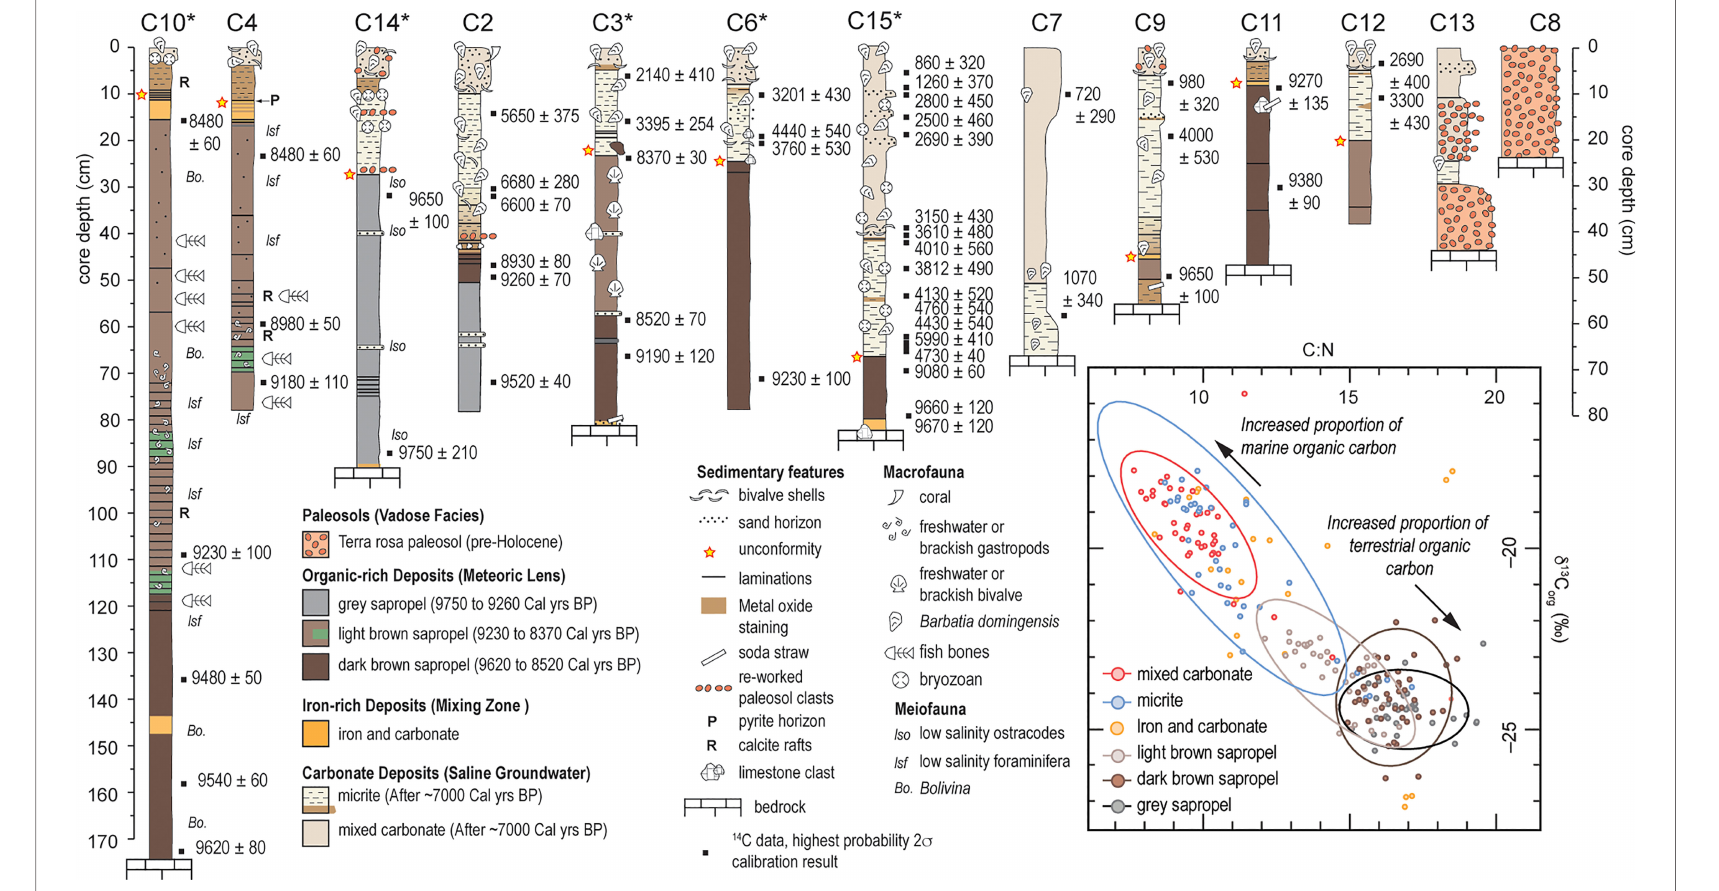
FIGURE 3 | Stratigraphic variability, preserved biologic remains, and radiocarbon ages (in Calibrated years before present) in each core represented as a visual core log. Inset depicts crossplot of d 13 C org and C:N values on sub-samples from cores marked with an asterisk to evaluate the relative contribution of terrestrial versus marine organic carbon to the sedimentary record, with 95% ellipse con fi dence intervals around the mean values for individual sedimentary units, except iron-rich carbonate unit. Note the greater range of values for the light brown (more nitrogen) vs. dark brown (less nitrogen)